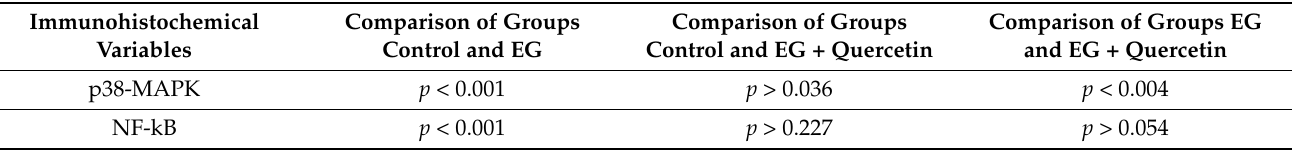
Table 2. Statistical data between groups in terms of p38-MAPK and NF-kB (Mann-Whitney test). Immunohistochemical Comparison of Groups Comparison of Variables